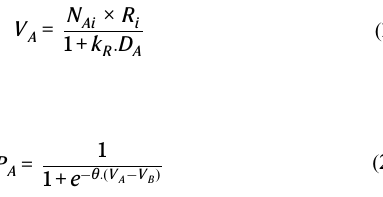
Fig. 1 | Behavioral tasks. Successive screens displayed in one trial are shown from left to right, with durations in ms. a Rating task. For each reward, effort and pun- ishment (not shown), participants indicated on a keyboard the quantity that had thesamesubjectivebene fi t(orsubjectivecost)thanearning(orloosing)1 € and5 € . b Intertemporal choice task. Participants fi rst observed the two options shown successively and then indicated their preference by pressing one of two buttons with the leftor right hand. The presentation order of sooner and later options was counterbalanced across trials. The task was divided into blocks of intertemporal choices between two rewards, two efforts, or two punishments (not shown). c ‘ Now/tomorrow ’ choice task. Participants were presented with an option